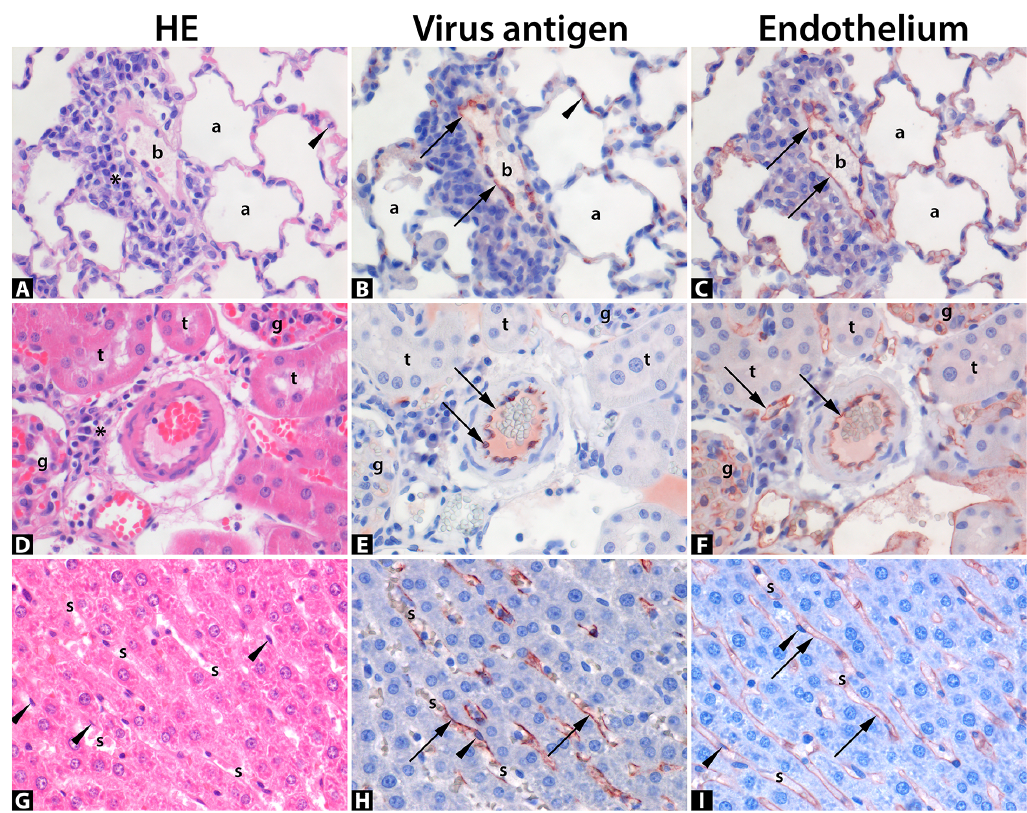
Figure 1. Histopathology of natural Seoul virus (SEOV) infection in feeder rats. Panel photomicrographs of lung ( A – C ), kidney ( D – F ), and liver ( G – I ) of naturally infected rats with Seoul virus, stained with haematoxylin & eosin (HE; ( A , D , G )), or by immunohistochemistry for virus antigen ( B , E , H ), or for endothelial cells ( C , F , I ). Positive antigen expression is visualized as finely-granular reddish-brown staining by AEC-immunoperoxidase, on Haematoxylin counterstain. Original magnifications 400 × . ( A ) Lung parenchyma shows a blood vessel (b) with a mild perivascular lymphoplasmacytic infiltrate (asterisk) and surrounding air-filled alveoli (a) with a polymorphonuclear leukocyte (arrowhead) in an alveolar septum; compared to serial section ( B ) showing SEOV-antigen expression within the flattened cytoplasm of endothelial cells (arrows) lining the blood vessel lumen (b) as well as lining capillaries within alveolar septa (arrowhead); compared to serial section ( C ) corroborating virus infection in endothelial cells by positive CD31-antigen expression (arrows) specific for endothelial cells. ( D ) Kidney parenchyma centrally shows a cross-section of a thick-walled arteriole, partly filled with erythrocytes, with a mild juxtavascular lymphoplasmacytic infiltrate (asterisk) and surrounded by several renal tubules (t) and two glomeruli (g); compared to serial section ( E ) showing positive endothelial cells’ cytoplasm for SEOV-antigen (arrows), compared to serial section ( F ) corroborating endothelial cells by positive CD31-antigen expression (arrows). ( G ) Liver parenchyma diagonally shows narrow sinusoids (s) in between hepatocellular cords. The sinusoids contain few erythrocytes and are lined by endothelial cells with nuclei slightly bulging into the sinusoidal lumens (arrowheads); compared to section ( H ) * showing abundant positive expression of the endothelial cell cytoplasm for SEOV-antigen (arrows); compared to serial section ( I ) corroborating endothelial cells by positive CD31-antigen expression (arrows). * Photomicrograph H pertains a representative liver section, not an exact serial